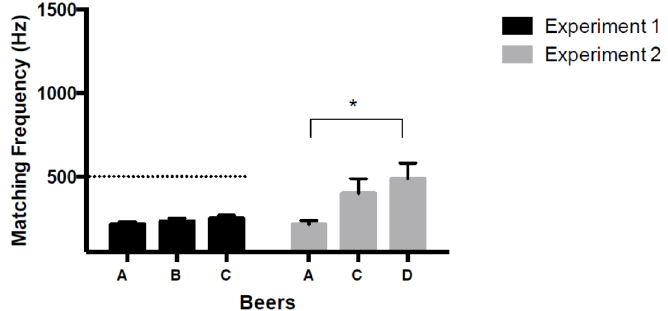
Figure 3. Means and SE of the tuning ratings of the participants in Experiments 1 and 2. The asterisk indicates a significant difference between ratings. Note that the dotted line refers to the upper limit of the pitch range available to choose from in Experiment 1 (500 Hz).